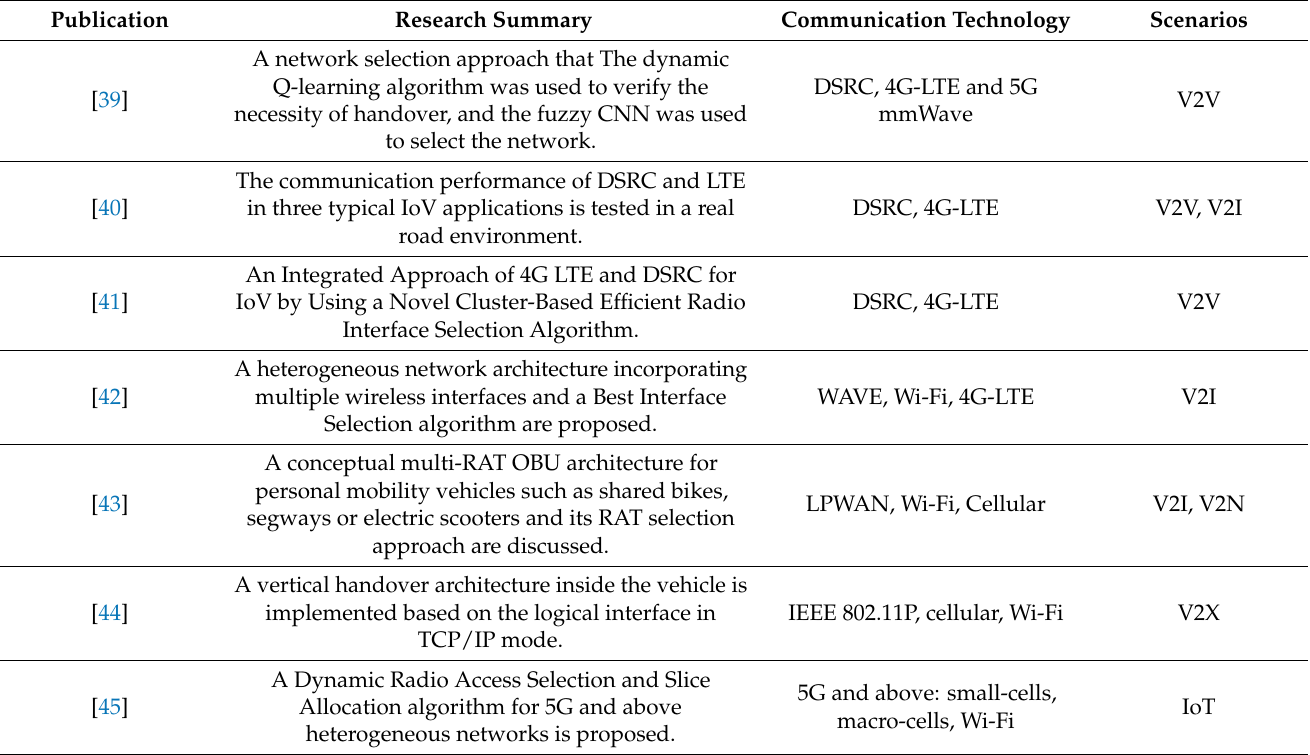
Table 1. Recentstudies on RAT selection in